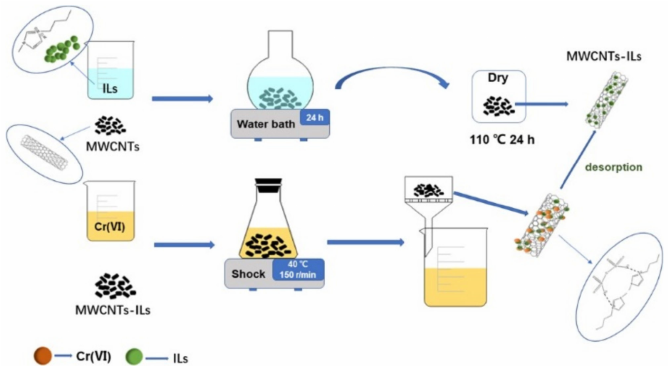
Figure 4. Preparation of IL@MWCNT composites and its utilization in the adsorptive removal Cr(VI) from water. Reprinted with permission from